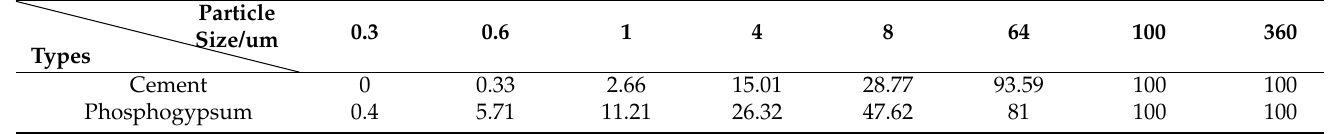
Table 2. Particle passing percentage of the raw